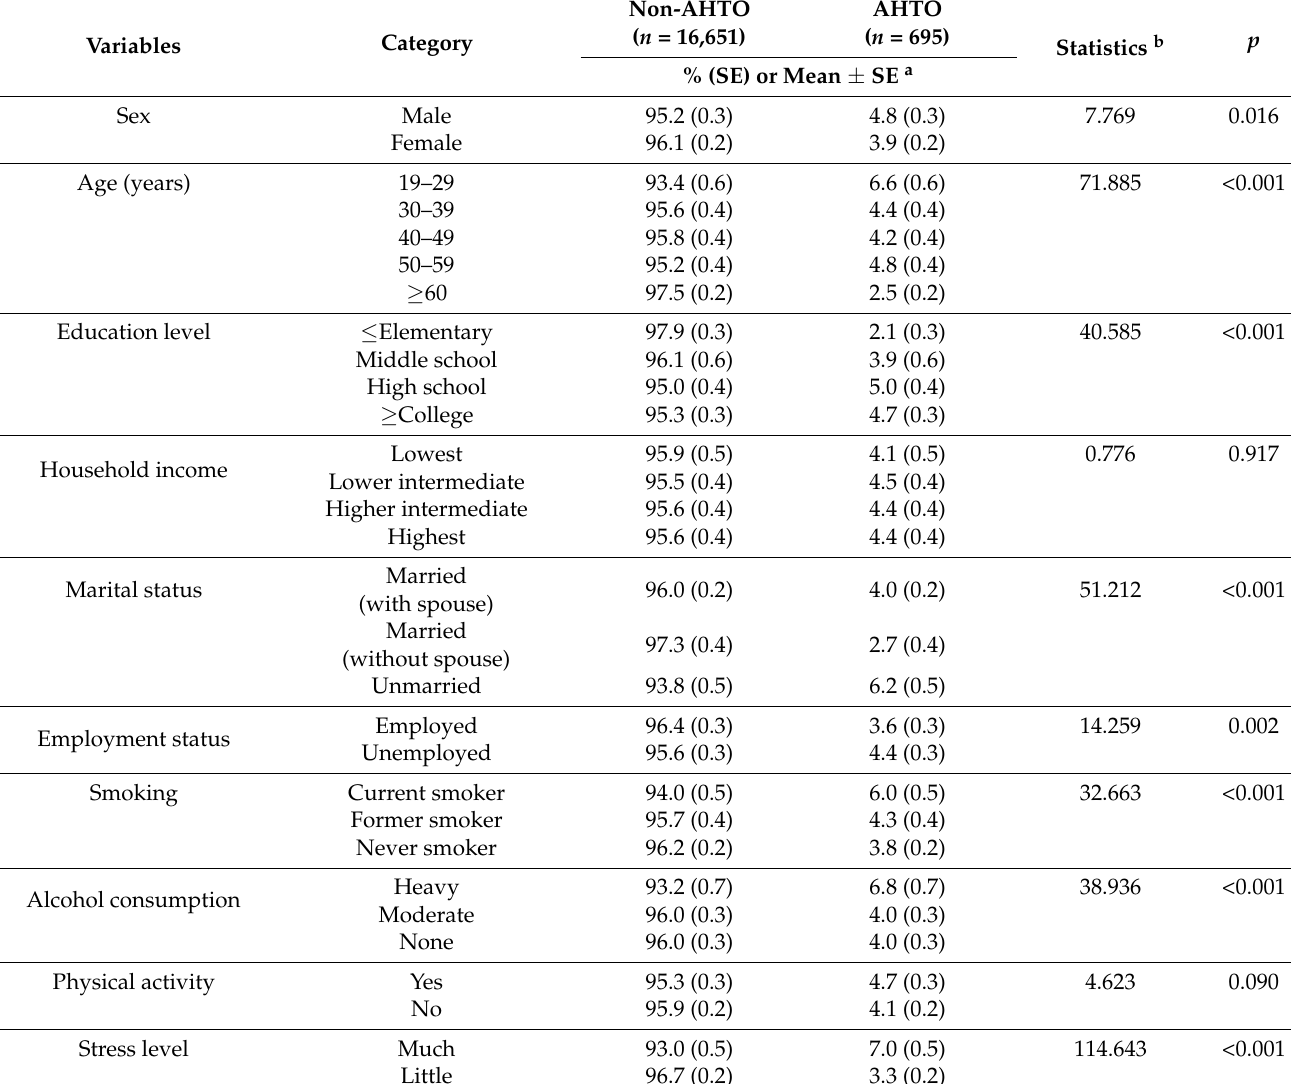
Table 1. Characteristics of study participants and exposure to